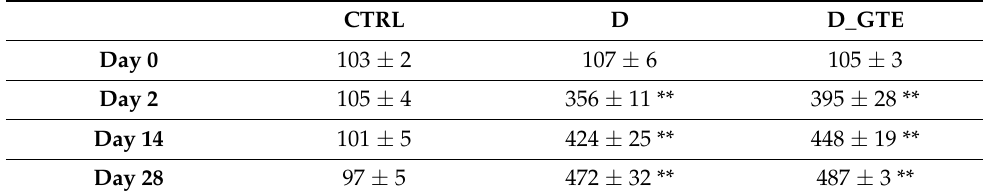
Table 2. Mean values ± SEM of blood glucose levels (mg/dL) measured in the CTRL group, and untreated (D) and GTE-treated (D_GTE) diabetic animals, at different time points during the experi- mental protocol. ** p < 0.01 vs. CTRL (Two-way ANOVA). CTRL